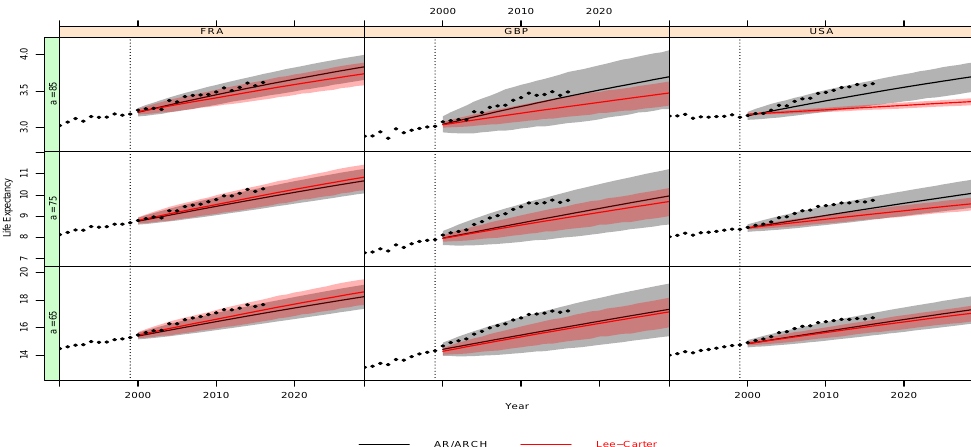
Figure A4. Life expectancy: Forecast life expectancy over the period of 2000–2030 at ages 65, 75, and 85 for the France, England and Wales, and US populations produced by both the selected AR-ARCH (black) model and Lee–Carter (red) model. The 95% prediction intervals are also included. The crude mortality over the observed period is also presented (black circles).